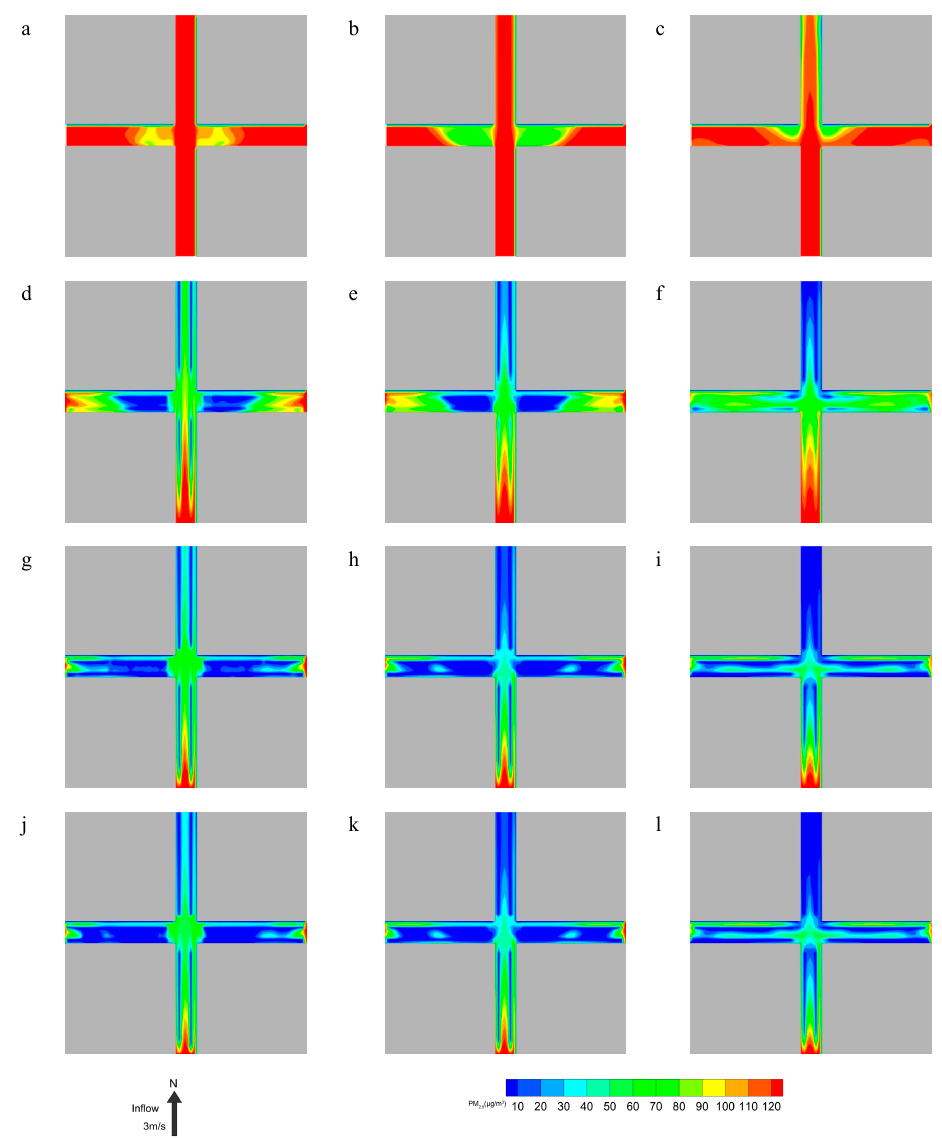
Figure 9. PM 2.5 distributions at z = 1.5 m in H/W = 0.5 ( left ), H/W = 1.0 ( middle ), and H/W = 2.0 ( right ) for tree-free scenarios ( a – c ), LAD = 0.5 ( d – f ), LAD = 1.5 ( g – i ), and LAD = 2.5 ( j – l ) with conical canopy.